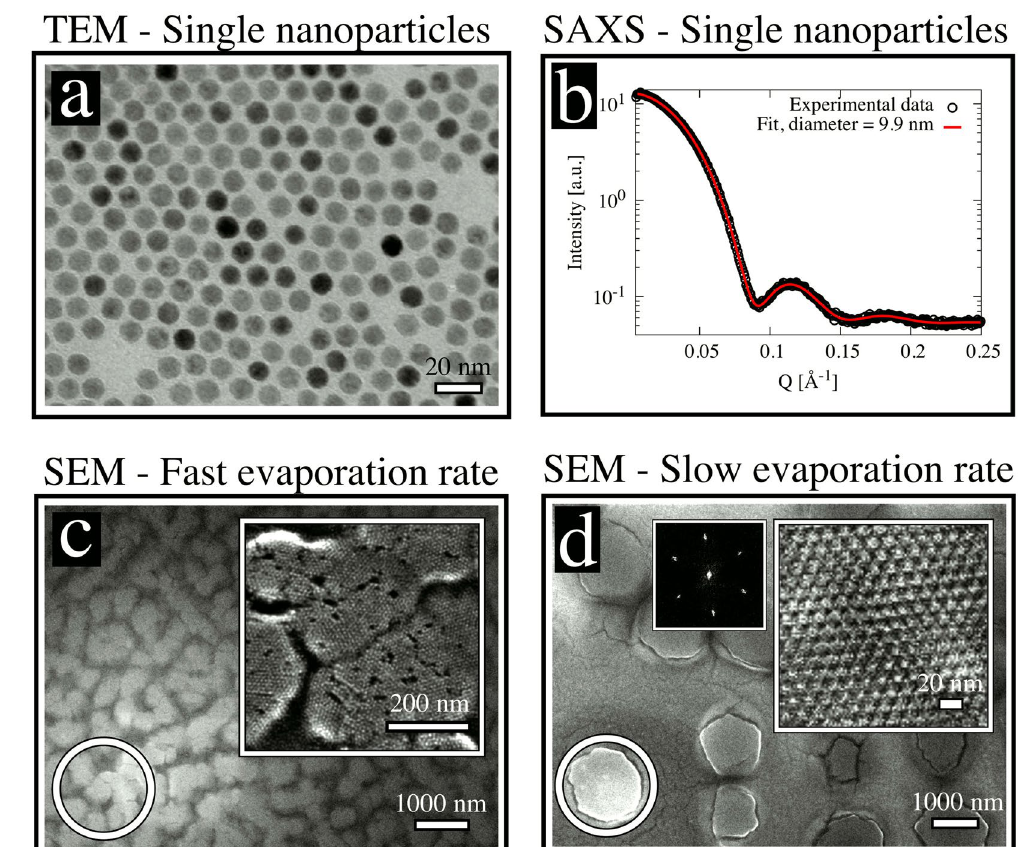
Figure 1. Characterisation of nanoparticles and superlattices. ( a ) TEM image of monolayer of spherical iron oxide nanocrystals. ( b ) SAXS pattern of a dilute nanoparticle dispersion together with the fit to the data with a spherical form factor. ( c , d ) SEM images of 3D nanoparticle superlattices produced at ( c ) fast and, ( d ) slow evaporation rates. The inset on the right corner shows a higher magnification of the marked area (circle). The inset on the left side of ( d ) is a fast Fourier transformation (FFT) of the